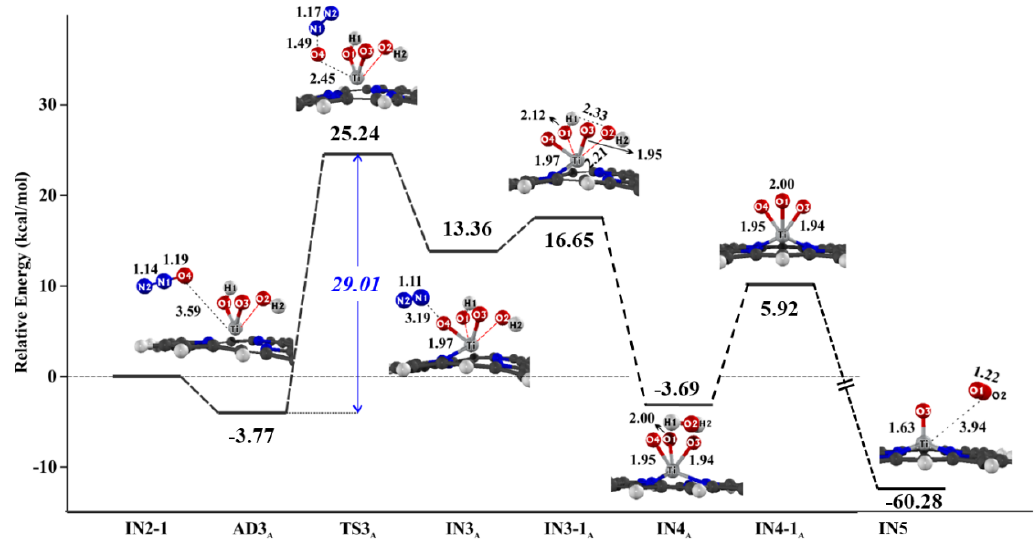
Figure 4. Path A: The second N 2 O decomposition followed by water desorption and oxygen formation.